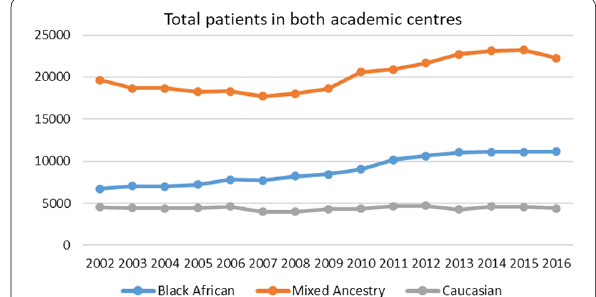
Fig. 2 Total admissions to both centres during the study